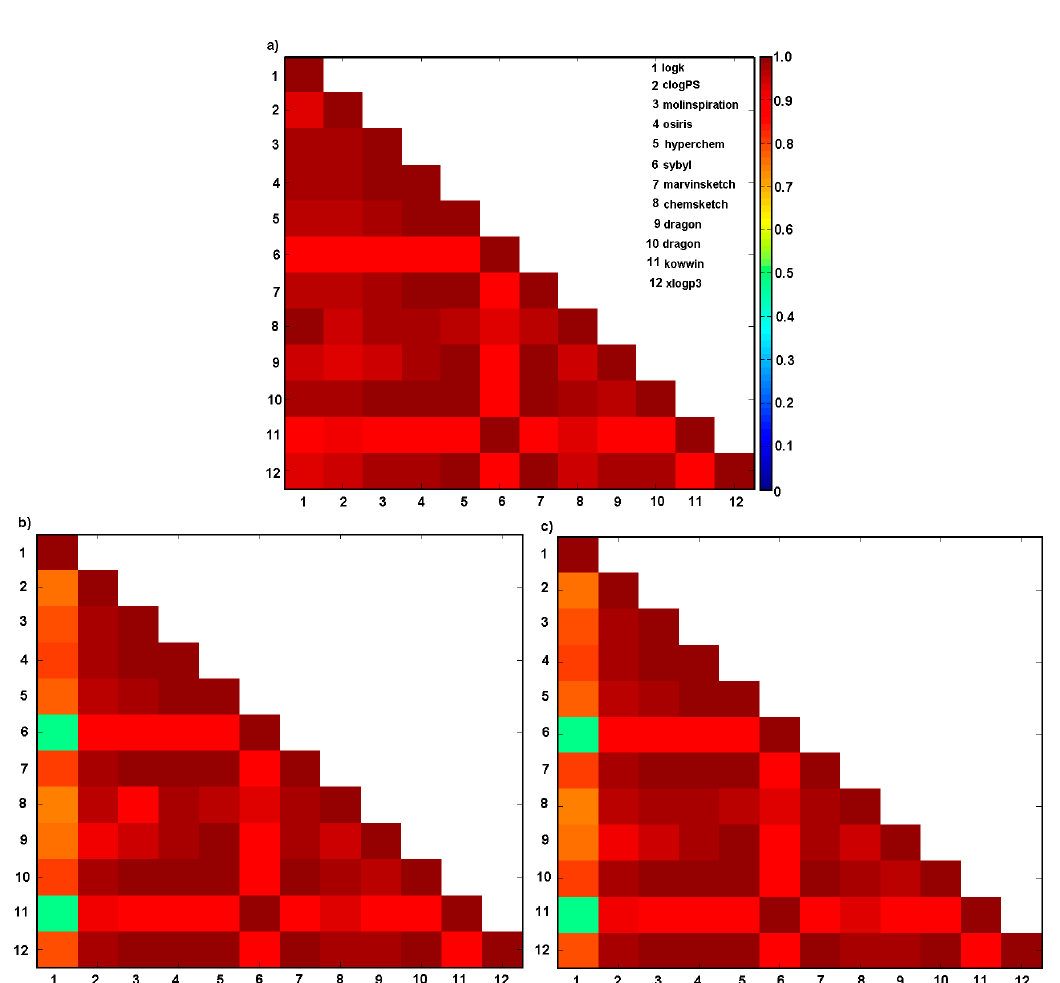
Figure 2. Matrix of correlation coefficients of linear relationships between experimental lipophilicity log k (1) and calculated lipophilicity with clogPS (2), Molinspirations (3), OSIRIS property explorer (4), HyperChem 7.0 (5), Sybyl X (6), Marvin Sketch (ChemAxon) 15 (7), ChemSketch 2015 (8), Dragon 6.0 (9), Dragon 6.0 (10), Kowwin (11), XlogP3 (12) methods for series ( a ) 1a – 19a , ( b ) 1b – 19b and ( c ) 1c – 19c